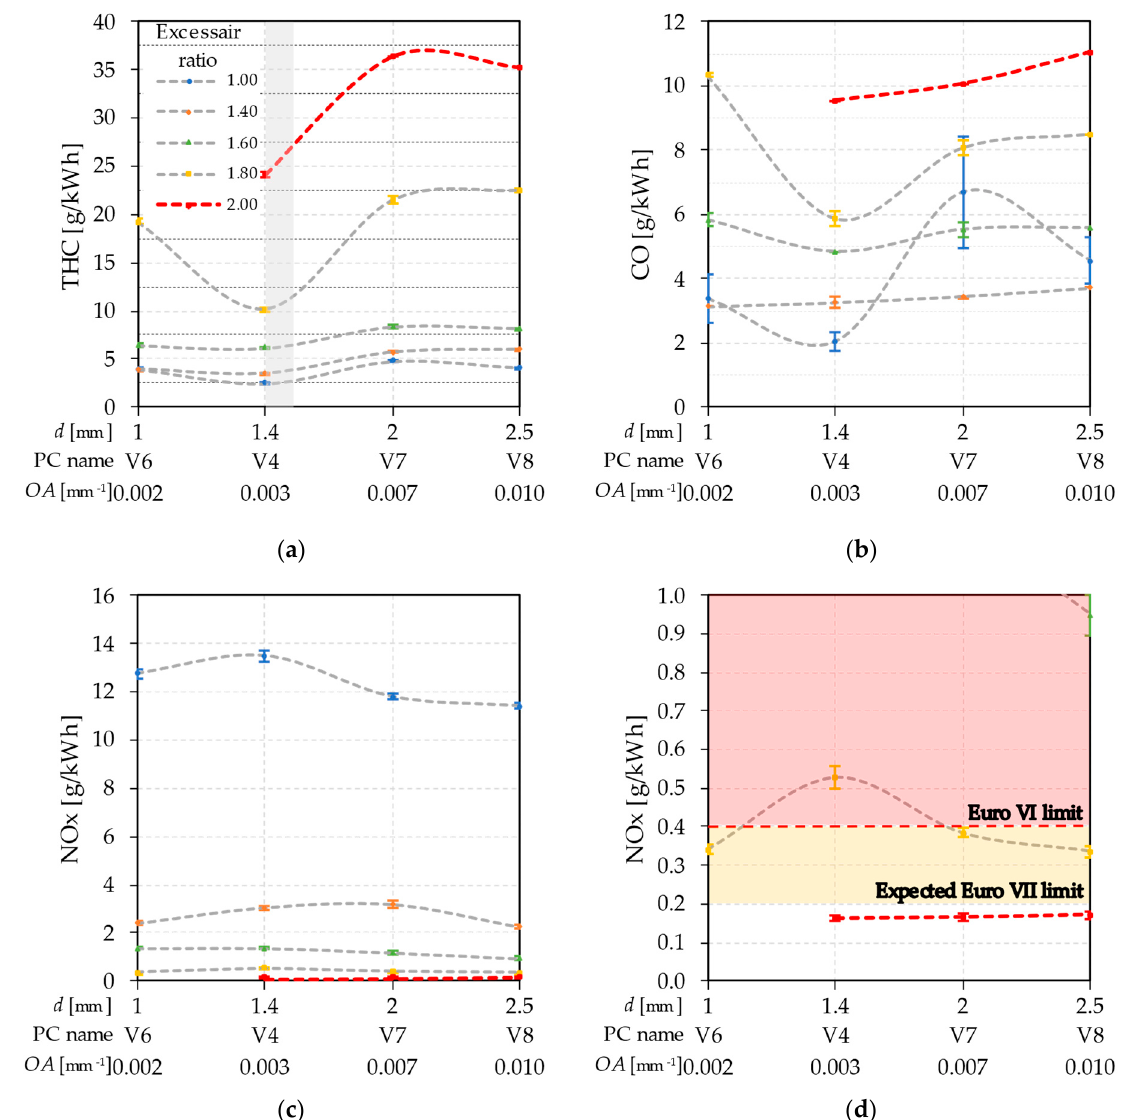
Figure 10. Influence of orifice diameters on engine emissions: ( a ) THC (shaded area is the OA area recommended by [9]); ( b ) CO; ( c ) NOx; and ( d ) NOx enlarged with legislative NOx limit. All pre- chambers have an VR = 3.27% and 4 orifices.